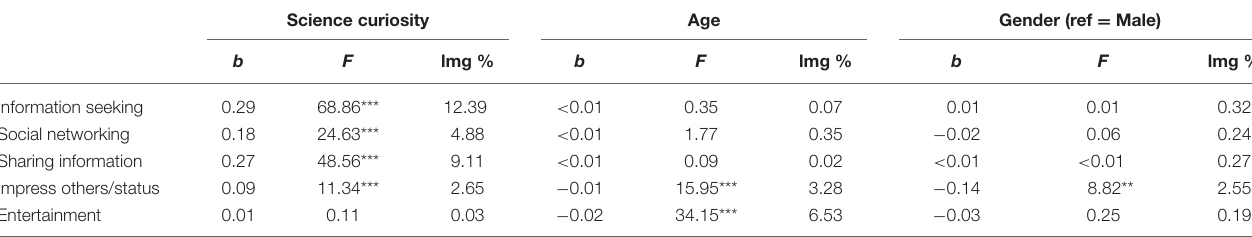
TABLE 3 | Predicting the different uses and gratifications of YouTube.